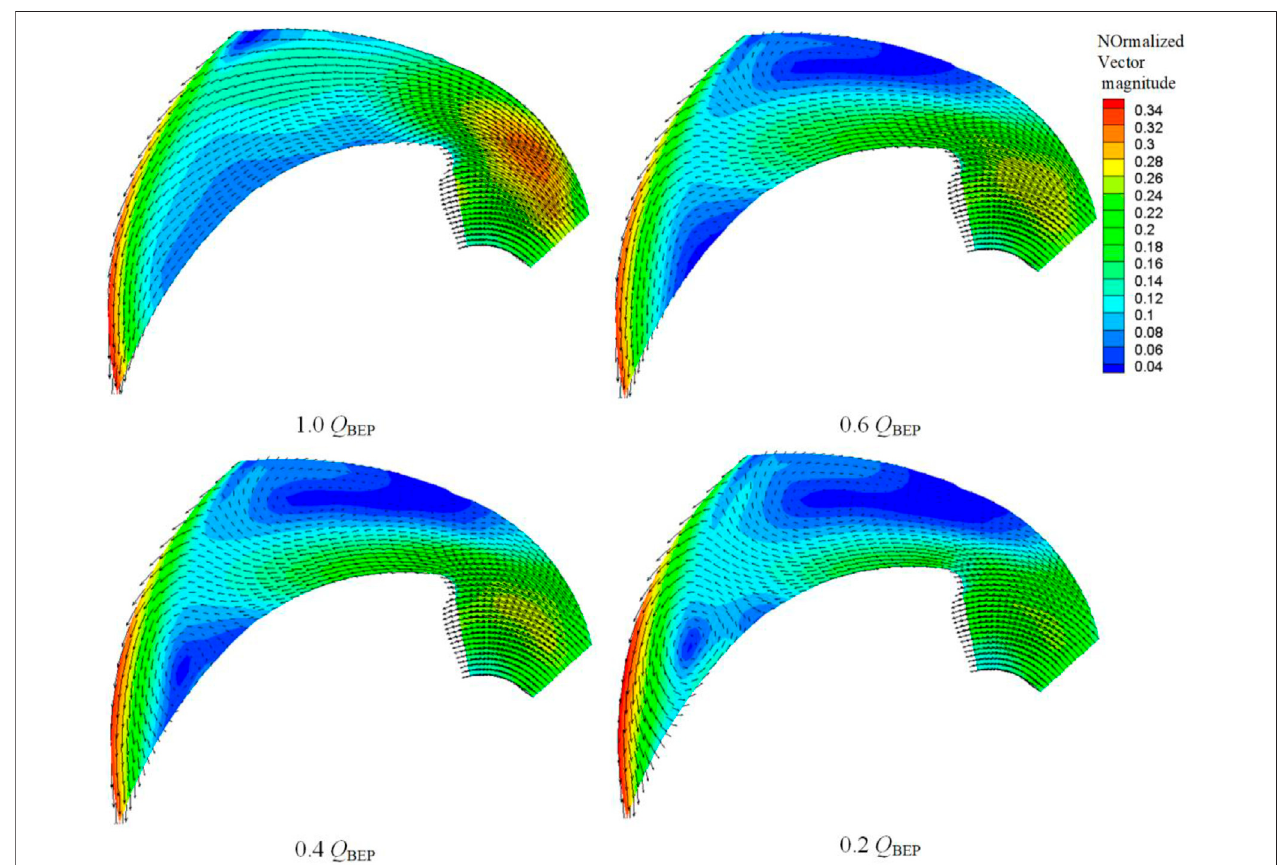
FIGURE 2 | Phase-averaged in-plane relative